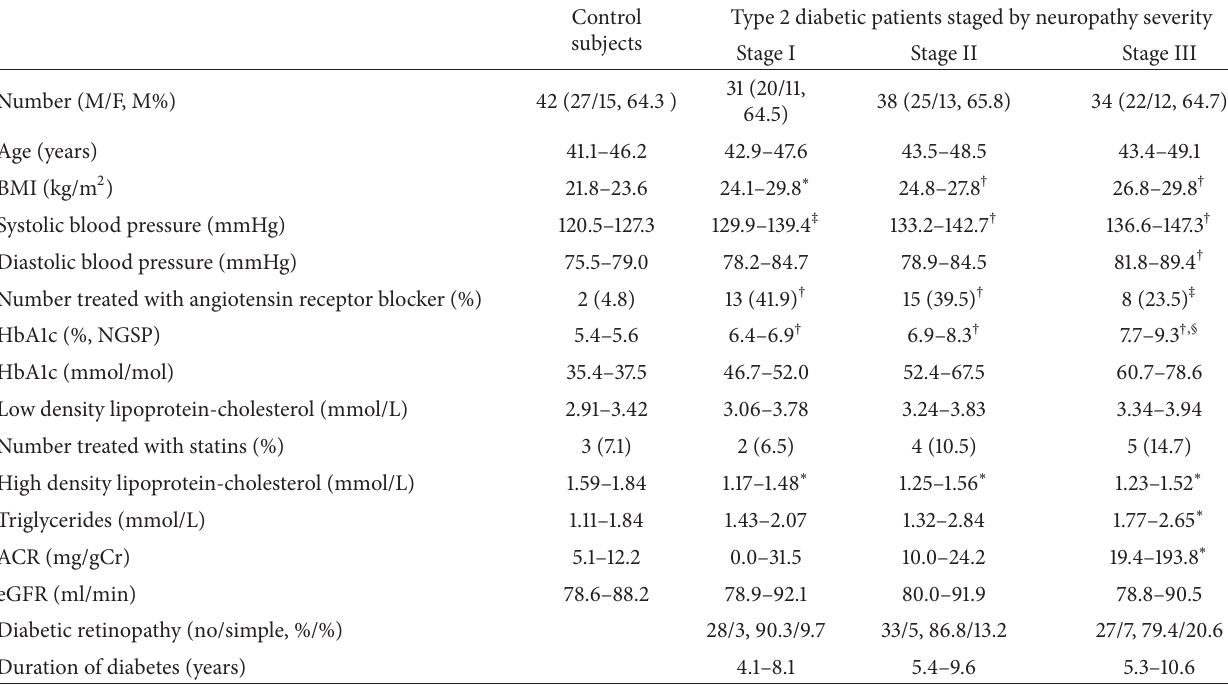
Table 1: Clinical characteristics in control subjects and subgroups of type 2 diabetic patients stratified by the severity of diabetic neuropathy.